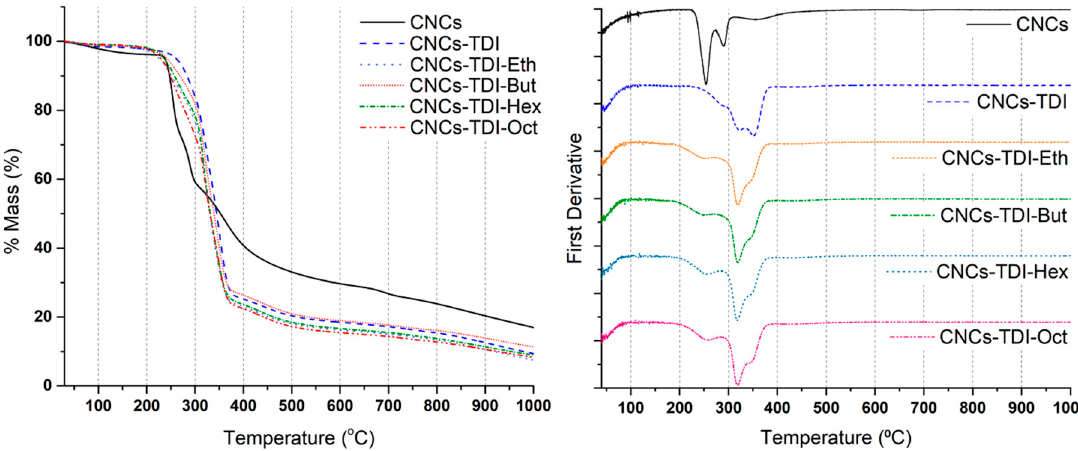
Figure 3. AFM height images of the CNCs before and after surface modification indicating no significant change in the morphology.